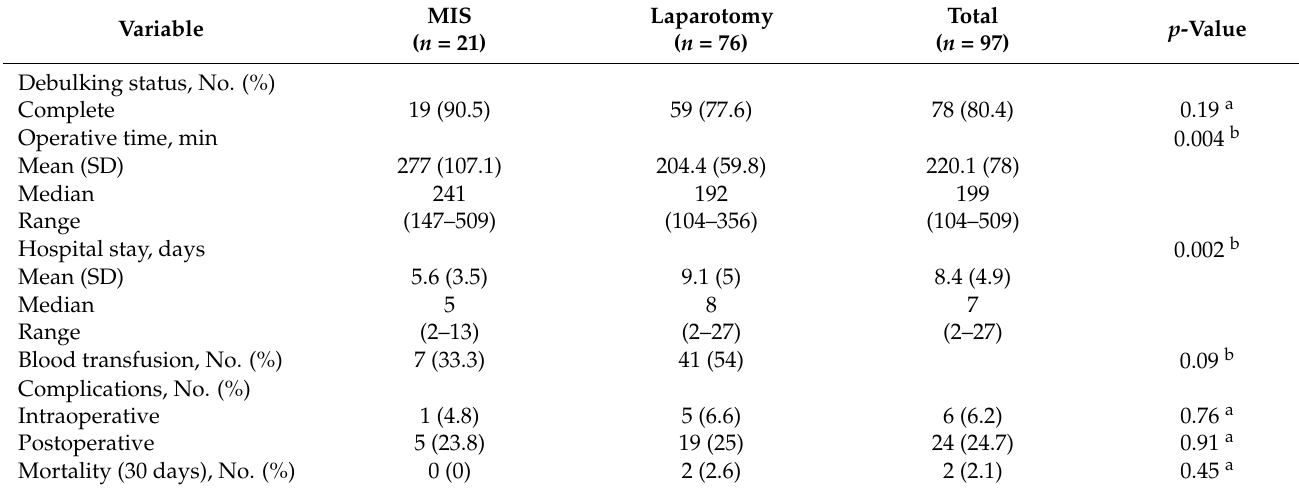
Table 3. Perioperative outcomes for the primary debulking group.